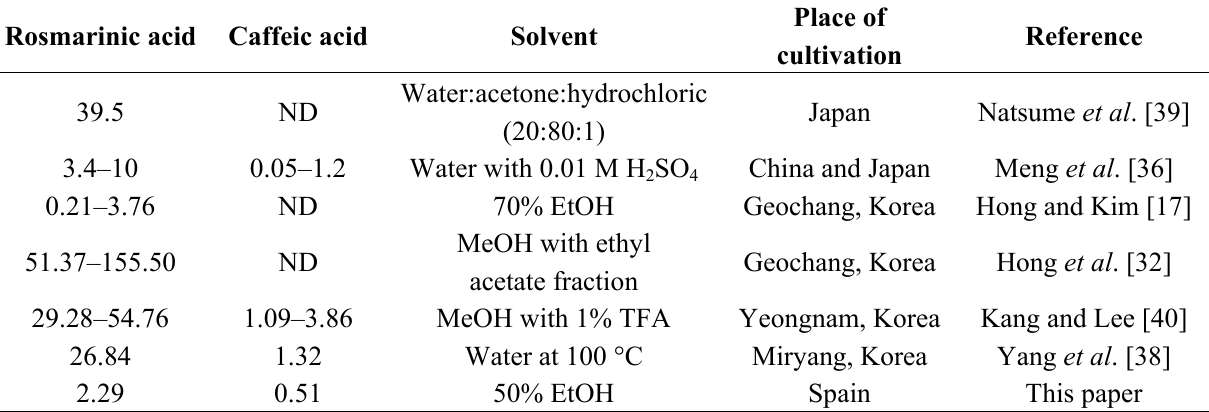
Table 3. Content of rosmarinic acid and caffeic acid in the perilla extracts (mg/g DW). Rosmarinic